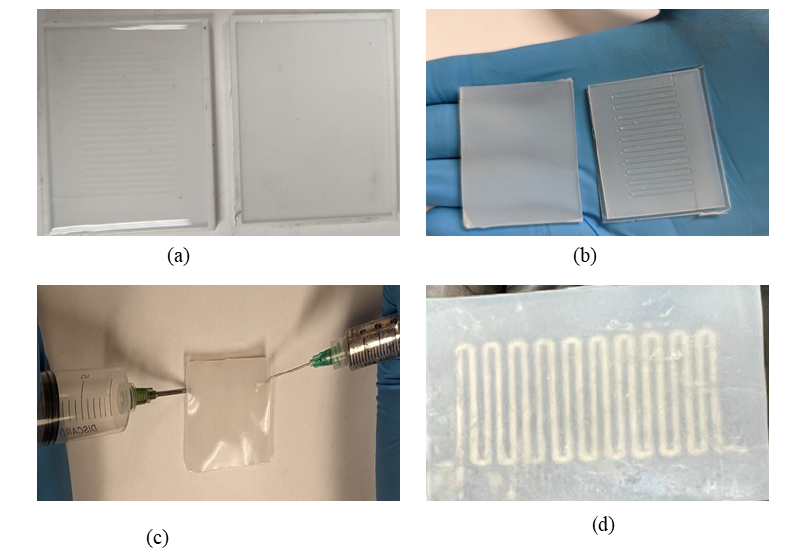
Figure 5. ( a ) Elastomer preparation phase, ( b ) top and bottom layer after curing the elastomer, ( c ) liquid metal injection in the microchannel, ( d ) fabricated sensor after liquid metal